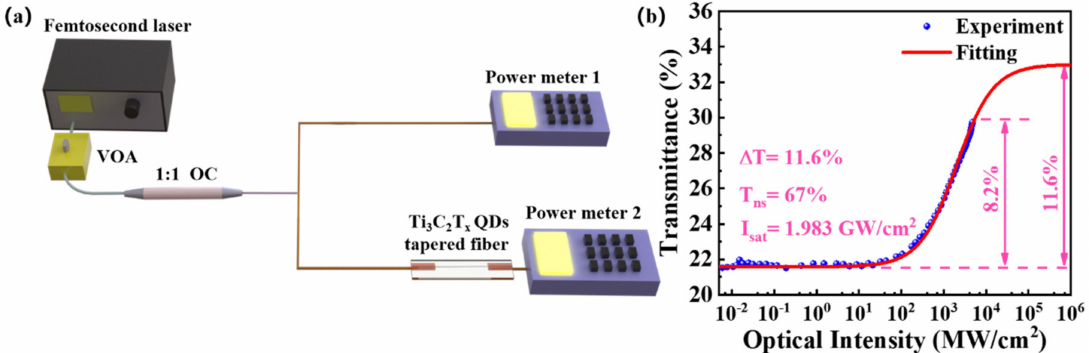
Figure 5. ( a ) Schematic diagram for the balanced twin-detector measurement system used for testing the Ti 3 C 2 T x QDs tapered fiber SA device. ( b ) Nonlinear transmittance of the Ti 3 C 2 T x QDs tapered fiber SA at wavelength of 1550 nm. It was fitted by a two-level saturable absorber